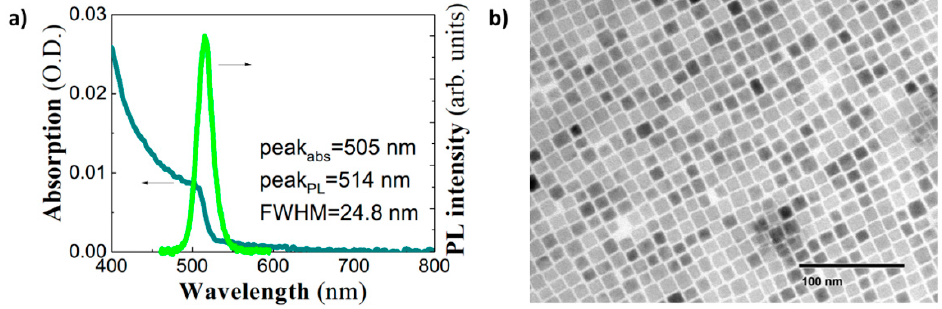
Figure 1. ( a ) Absorbance (blue continuous line) and PL (green continuous line) spectra of CsPbBr 3 PNCs dispersed in hexane; and ( b ) TEM image of cubic CsPbBr 3 PNCs. The average cube side is around 10